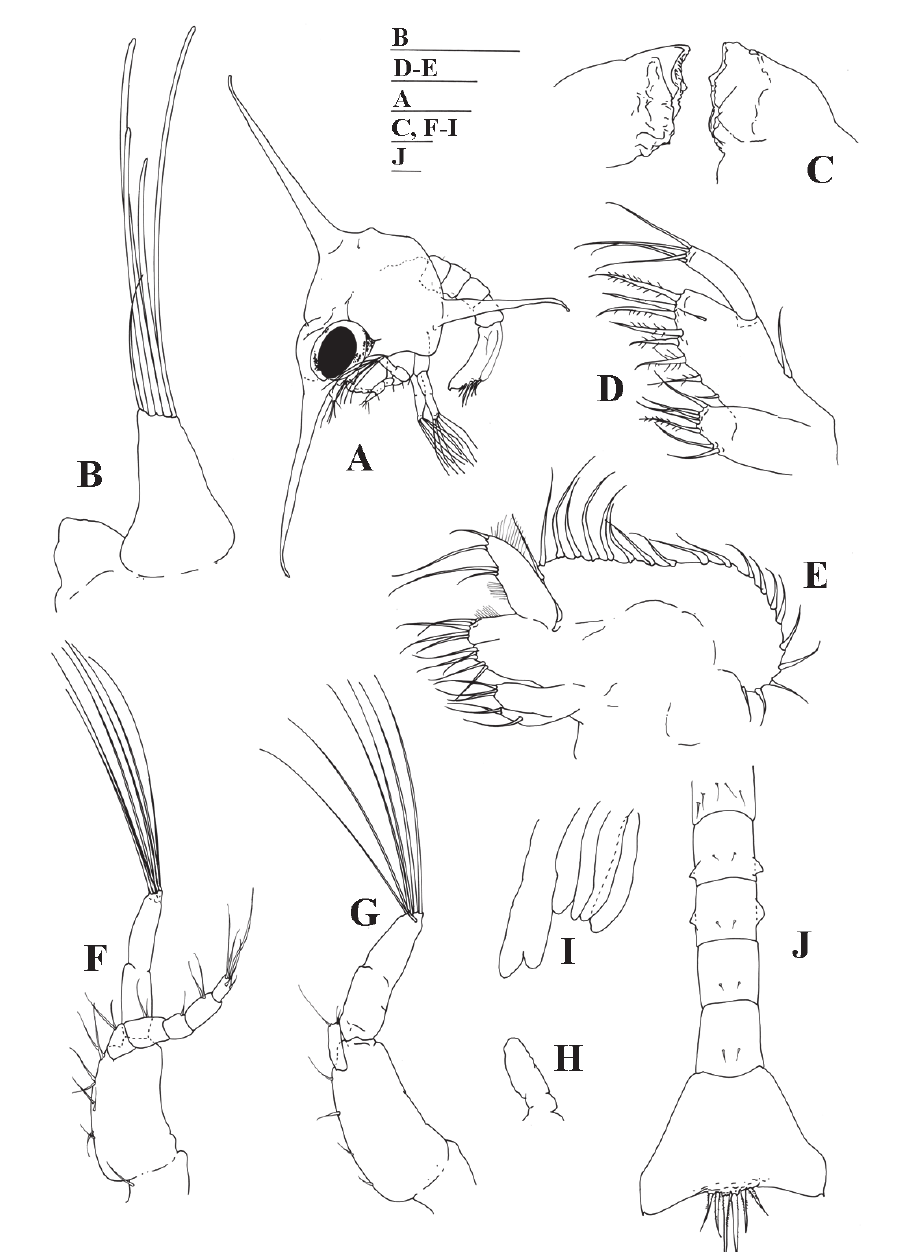
Fig . 2. – Ilia nucleus . second zoea: a, general aspect, lateral view; B, antennule and antenna; C, mandibles; d, maxillule; e, maxilla; F, first maxilliped; g, second maxilliped; H, third maxilliped; i, pereiopods; J, dorsal view of abdomen and telson. scale bars: 0.5 mm (a); 0.1 mm